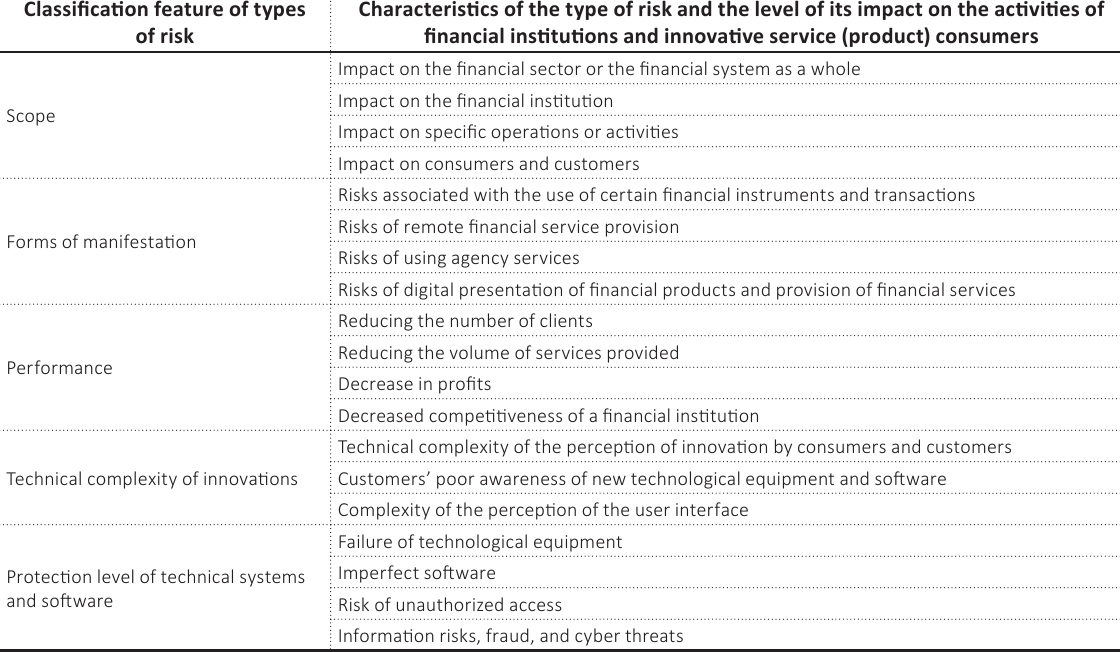
Source: Developed by the